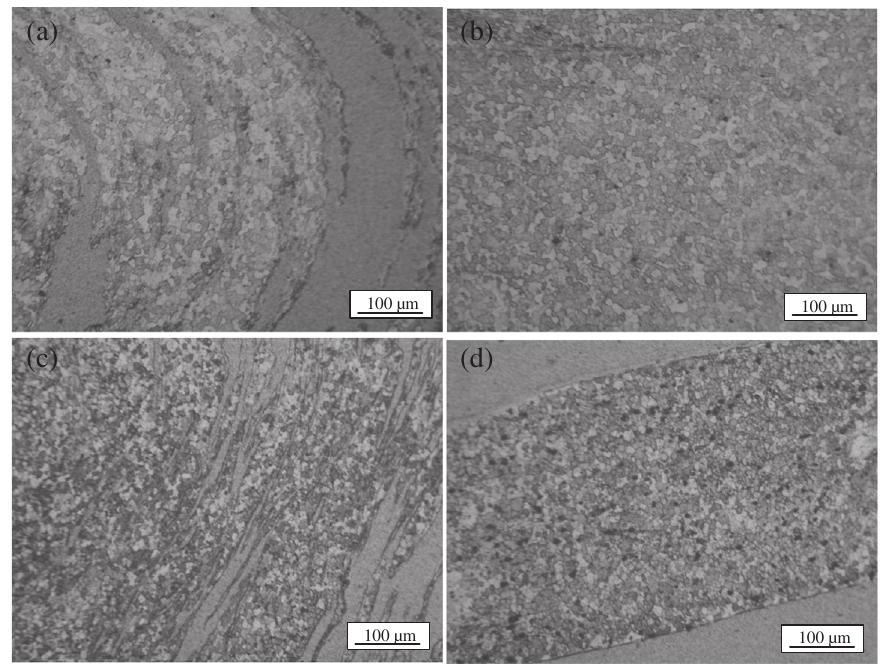
Figure 9: Microstructures of joints under different welding speeds: (a) top and (b) bottom at the welding speed of 50 mm/min; (c) top and (b) bottom at the welding speed of 200 mm/min.